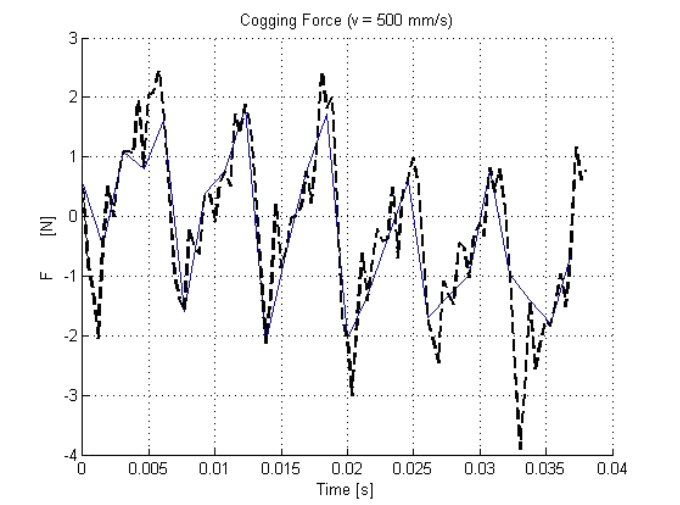
Figure 12. Trend of the Cogging Force: the predicted (thin line) compared with the measured (bold